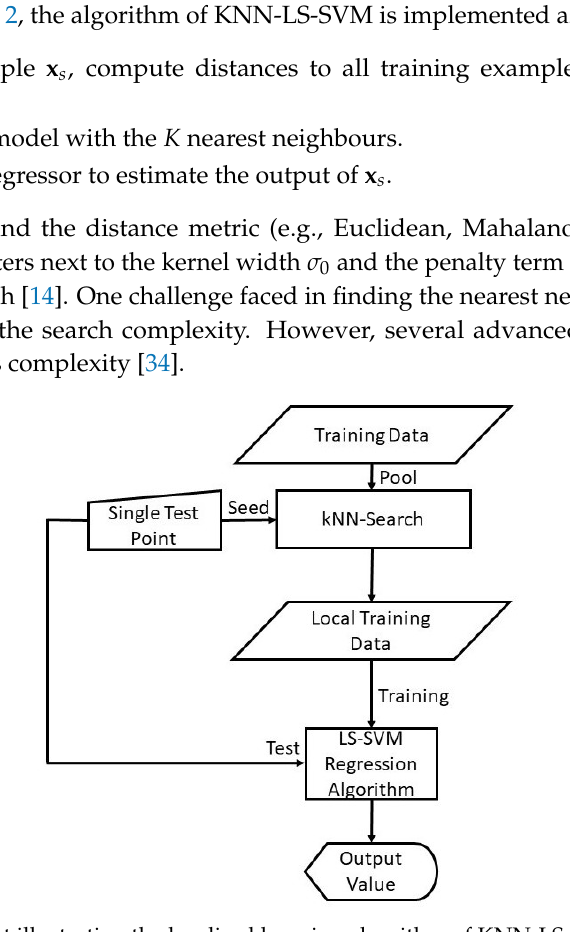
Figure 2. A flow chart illustrating the localised learning algorithm of KNN-LS-SVM for